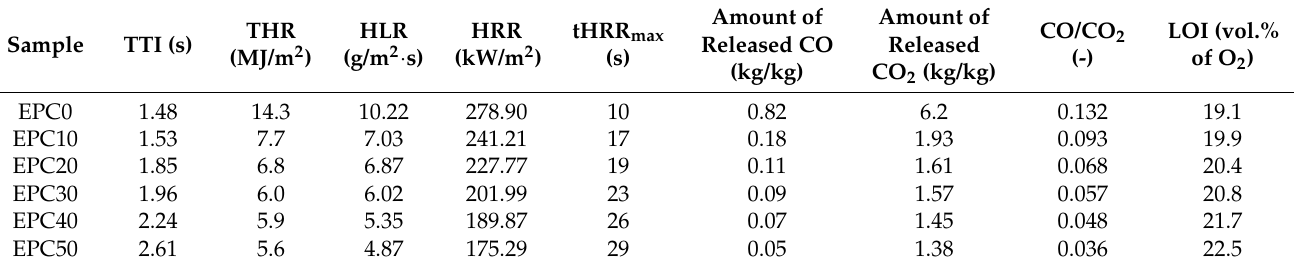
Table 5. Results of the flammability tests of selected RPU/PIR